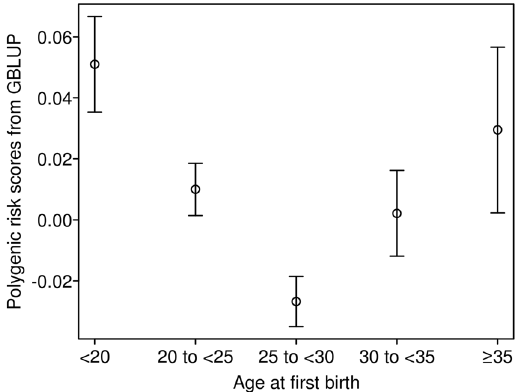
Figure 2. Mean and standard error of schizophrenia polygenic risk scores estimated from Genomic Best Linear Unbiased Prediction (GBLUP) in the UK Biobank sample grouped by age at first birth.